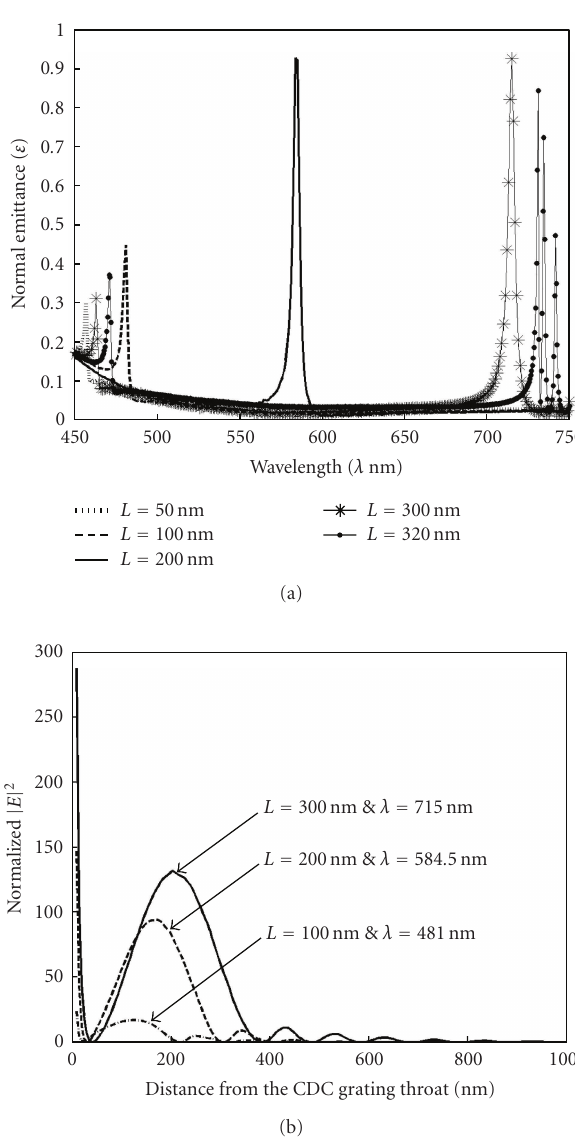
Figure 6: (a) Normal emittance spectrum with p -polarization in vacuum for Ag CDC grating having the parameters Λ = 250 nm, h = 100 nm, t = 100 nm, g = 5nm, and a photonic crystal having the parameters a = 100 nm, d 1 = d 2 = 50nm with cavity length L = 50 nm, L = 100 nm, L = 200nm, L = 300 nm, L = 320 nm; (b) electric field intensity distribution normalized to the incident along the line passing through the center of the CDC grating throat and into the photonic crystal with cavity lengths L = 100 nm, L = 200 nm, L = 300 nm, and at respective normal emissive peak